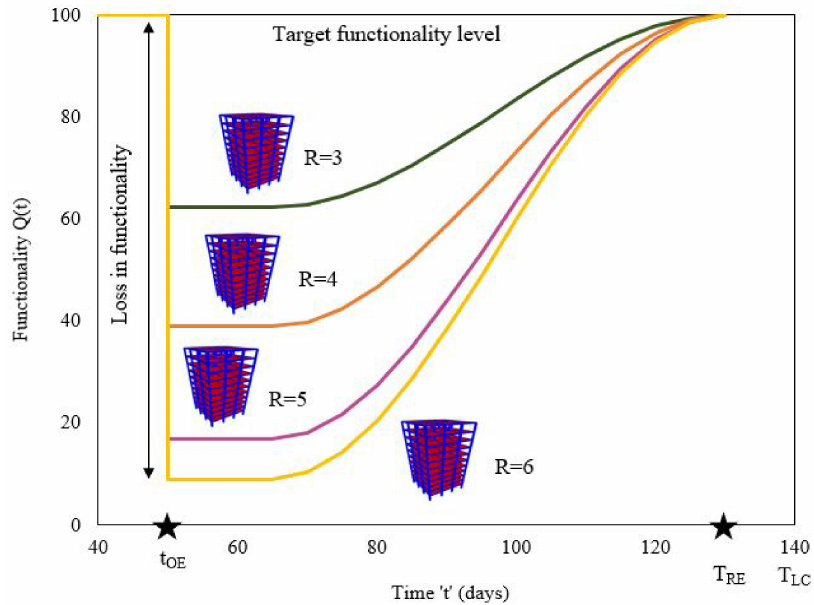
Figure 8. Graphical representation on functionality curves with respect to R factor. The time of occurrence of a seismic event is designated as t OE , its recovery time is designated as T RE .